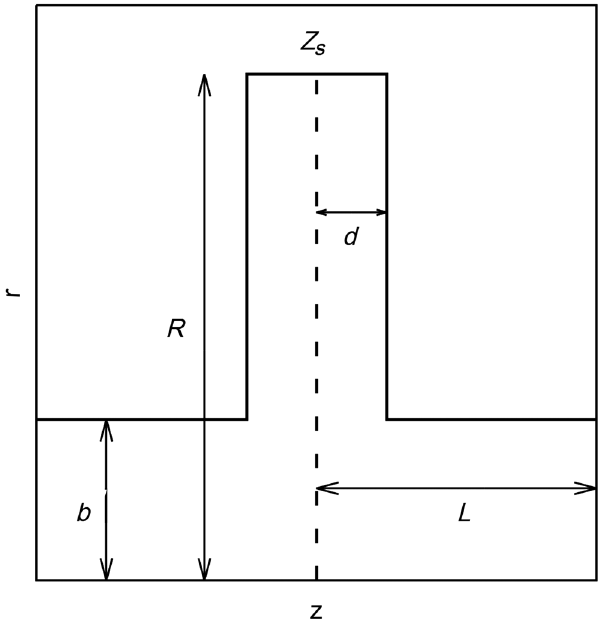
FIG. 1. Idealized geometry of LIA accelerating gap. The radial coaxial line is terminated at r ¼ R by an impedance of Z S . The gap and beam pipe are both axisymmetric and bilaterally symmetric about the dashed vertical line. In the treatment of Briggs, L → ∞